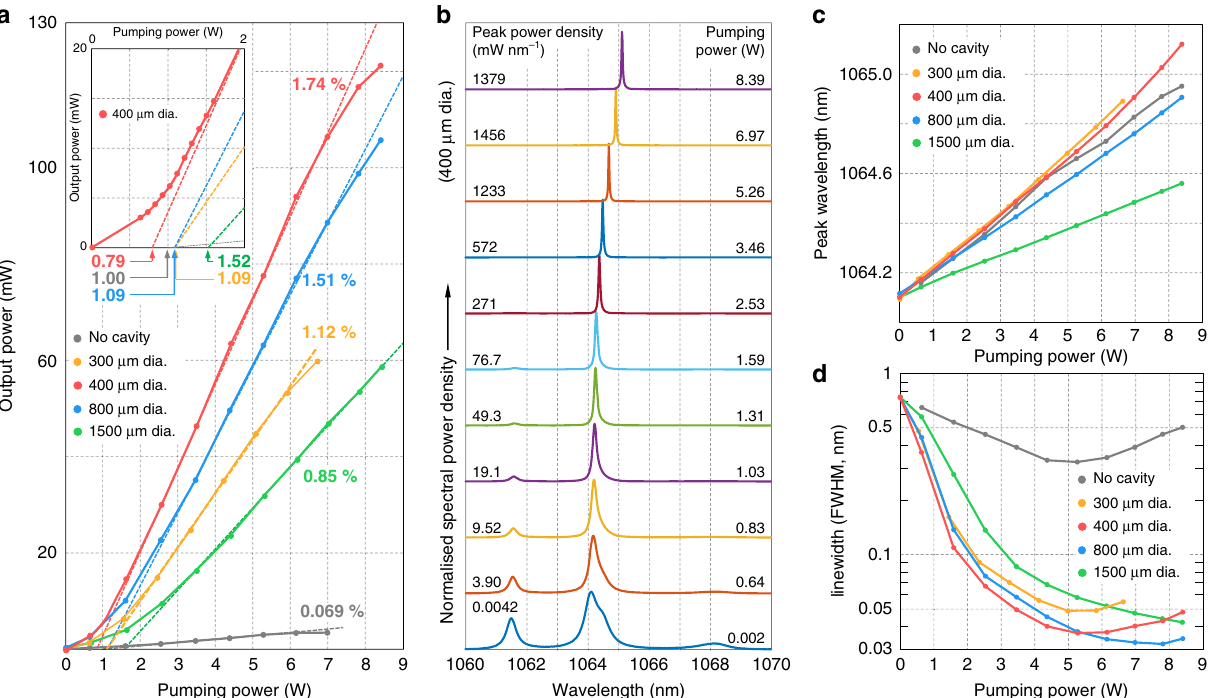
Fig. 3 Power and spectral properties. a Measured output powers for different cavity diameters. The inset shows the fi ner measurements near the threshold for a 400 μ m-diameter cavity. The extrapolated thresholds are shown below. b Normalized spectra for a 400 μ m-diameter cavity. The corresponding peak power density and pumping power are shown on the left and right sides of the peak, respectively. Note that the sampled pumping powers are not equally spaced. c Measured peak wavelengths for different cavity diameters. d Measured linewidths in terms of full width at half maximum (FWHM) for different cavity diameters. Notice the log scale of the y